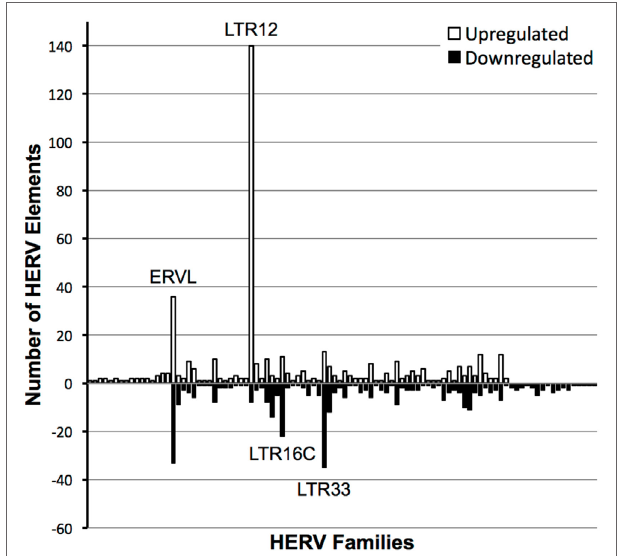
FigUre 1 | Number of distinct human endogenous retrovirus (HERV) elements per HERV family modulated by vorinostat treatment. HERV elements significantly differentially expressed (false discovery rate-corrected p -value < 0.05) with a log 2 fold change of greater than 3 or less than − 3 between vorinostat treated and untreated samples are depicted. HERV elements were grouped into HERV families according to designations in the Human Endogenous Retrovirus Database. White bars represent the number of HERV elements upregulated by vorinostat and black bars the number of downregulated elements. For example, there were 140 distinct HERV elements belonging to the LTR12 family which were significantly upregulated with a log 2 fold change greater than 3 by vorinostat